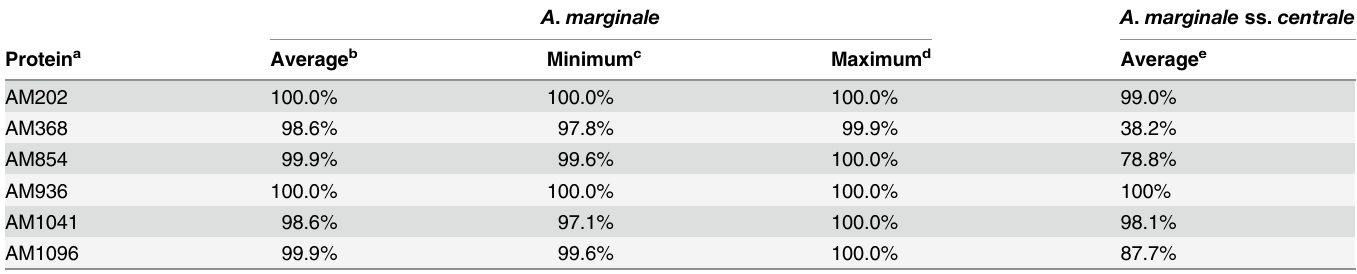
a. The St. Maries strain locus tag for each candidate protein. b. Average of the pairwise identity scores for each protein among all sensu stricto strains and isolates. c. Minimum of the pairwise identity scores for each protein among all sensu stricto strains and isolates. d. Maximum of the pairwise identity scores for each protein among all sensu stricto strains and isolates. e. Average of the pairwise identity scores for each protein when comparing all sensu stricto sequences to the A . marginale ss. centrale ortholog.